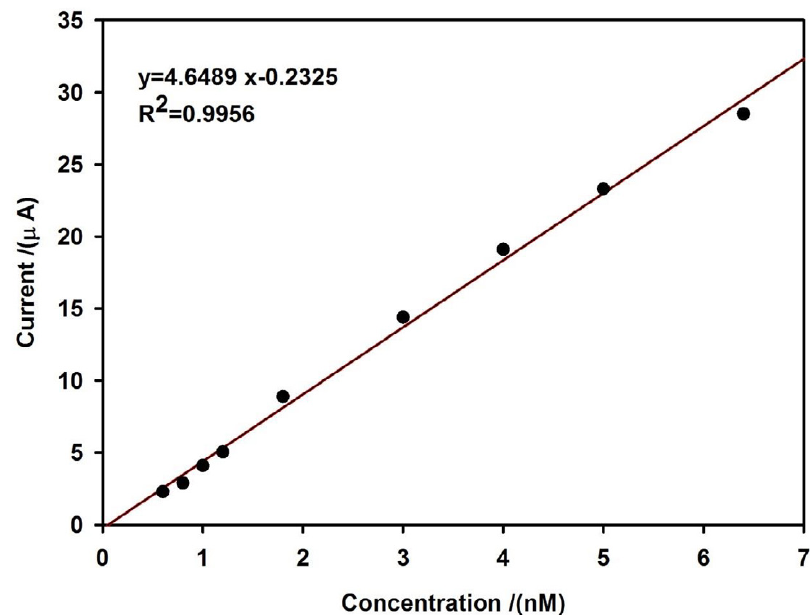
Fig.7. calibration curve of Aunanorods/g-C 3 N 4 modified GCE electrode in different concentration of target DNA